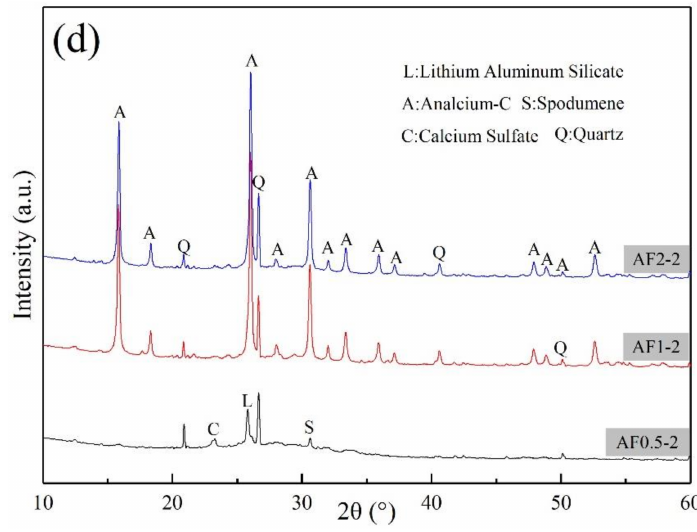
Figure 3. XRD patterns: ( a ) MLS, ( b ) AFs with different AA modulus, ( c ) time, ( d ) pressure.